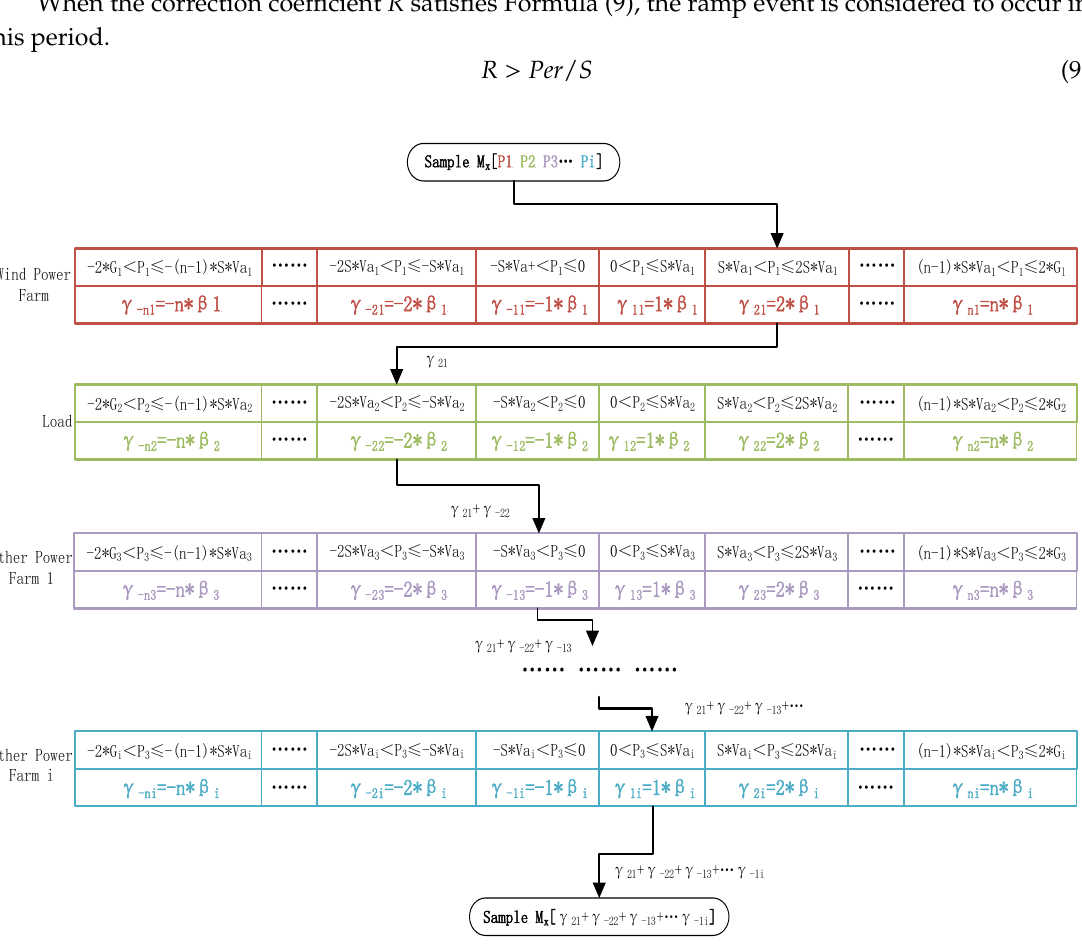
ffi cient correction model